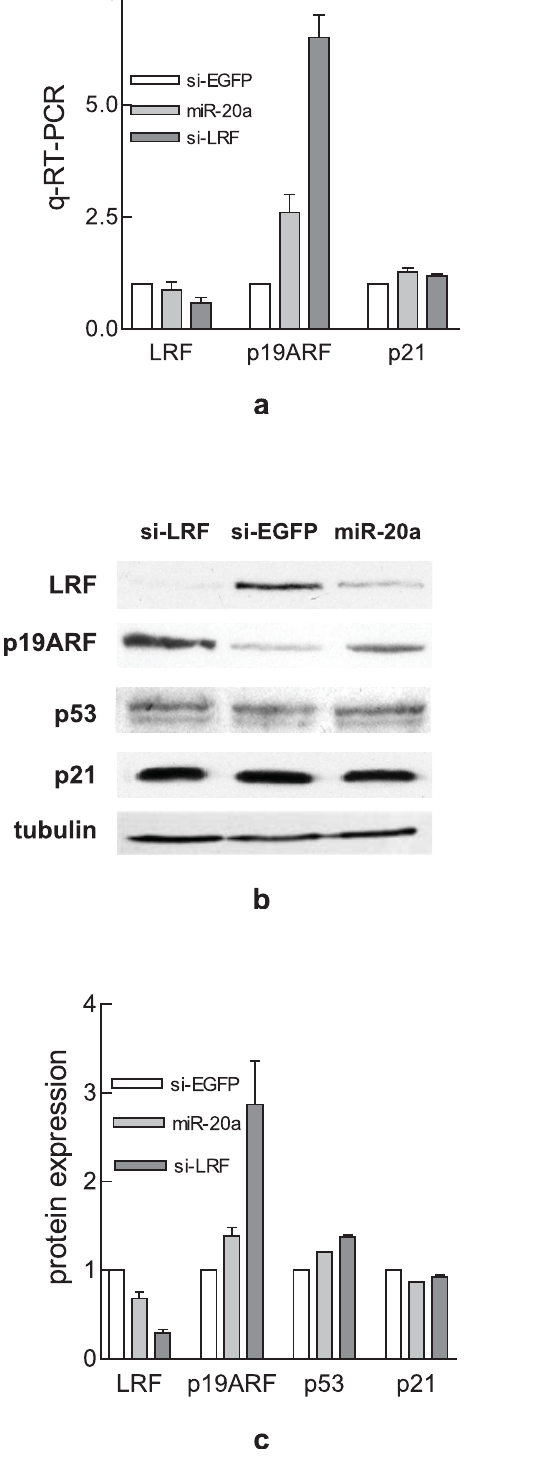
Figure 2. Effects of miR-20a on LRF-p19ARF pathway . a: q-RT- PCR of LRF, p19ARF and p21. Total RNA was extracted from MEF transfected with miR-20a, si-LRF or si-EGFP. mRNA level, detected by Real-Time PCR, was normalized to that of GAPDH. The values are the mean of two independent experiments. Western blot (b) and quantification (c) of LRF, p19ARF, p53 and p21. The band intensity was normalized to that of tubulin. Each bar represents the mean relative expression of LRF 6 SE of three independent experiments.